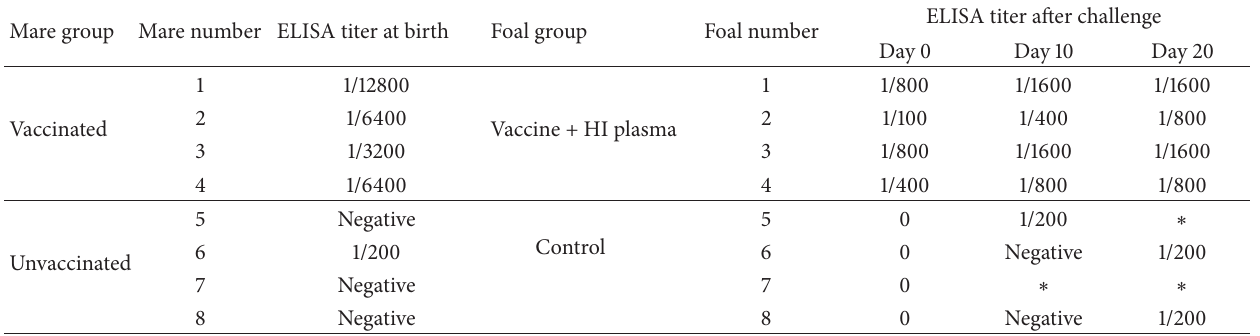
Table 2: Anti- R. equi antibody ELISA titer of vaccinated and unvaccinated mares and challenged foals. Mare group Mare number ELISA titer at birth Foal group